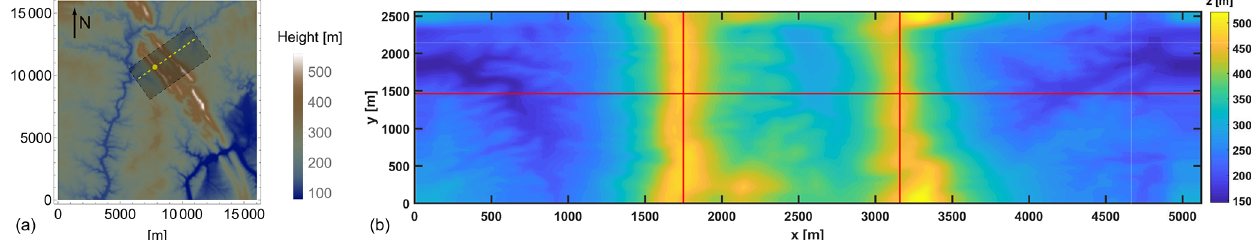
Figure 1. Terrain elevation variation at Perdigão. (a) Shaded rectangle represents the simulated area, with a yellow line passing through the main transect of the turbine location (source: Berg et al., 2017); (b) shaded region from (a) with intersection of red lines representing the turbine locations.